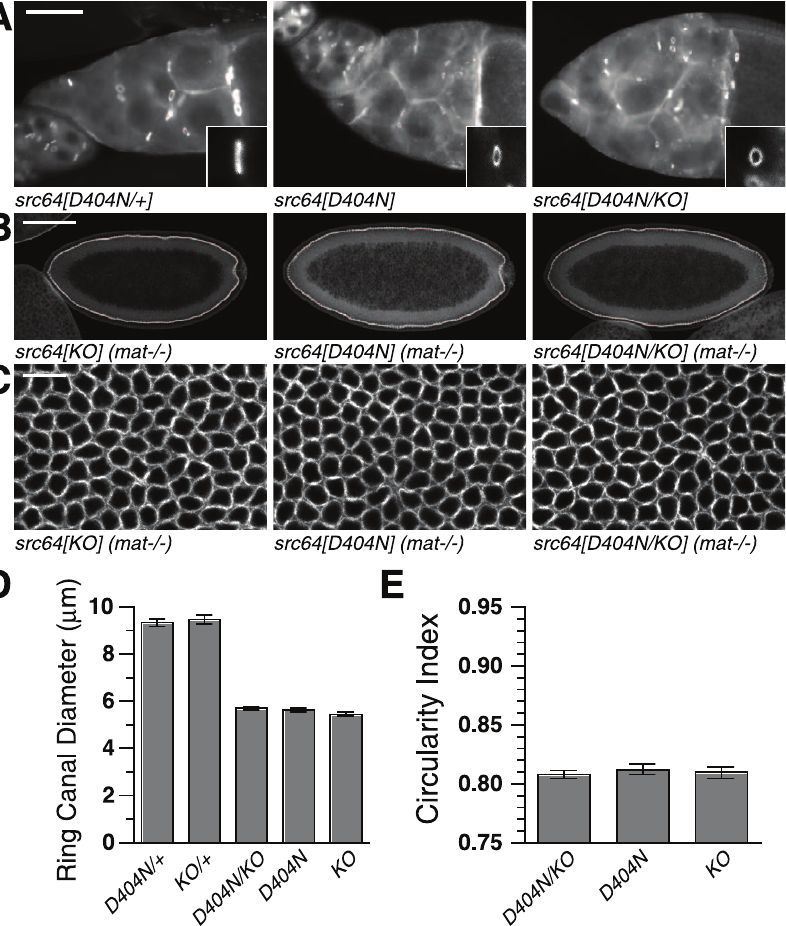
Figure 5. Cytoskeletal defects of src64 D404N /src64 KO trans -heterozygotes. (A) src64 D404N / + , src64 D404N and src64 D404N /src64 KO egg chambers stained with antibody to HTS. Ring canal diameters are not reduced in src64 D404N / + egg chambers but are reduced in src64 D404N /src64 KO egg chambers. Inset: ring canal of approximately mean diameter, reoriented so that diameter is projected along the vertical axis. Scale bar, 50 m m. (B) Early cellularization stage embryos laid by src64 KO , src64 D404N and src64 D404N /src64 KO mothers. Embryos show non-uniform cellularization fronts. Scale bar, 100 m m. (C) Grazing section projections of early cellularization stage embryos laid by src64 KO , src64 D404N and src64 D404N /src64 KO mothers showing microfilament networks. Microfilament ring defects of maternally trans -heterozygous src64 D404N /src64 KO embryos are similar to those of src64 KO and src64 D404N embryos. Embryos are stained with antibody to myosin II heavy chain. Scale bar, 10 m m. (D) Ring canal diameters. src64 D404N and src64 D404N /src64 KO do not differ (p=0.35). Error bars are SEM. (E) Microfilament ring circularity during early cellularization. src64 D404N and src64 D404N / src64 KO do not differ (p=0.52). Error bars are SEM.